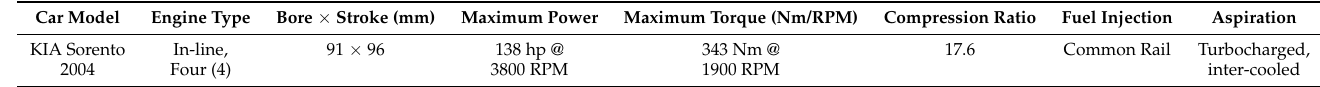
Table 1. Test engine